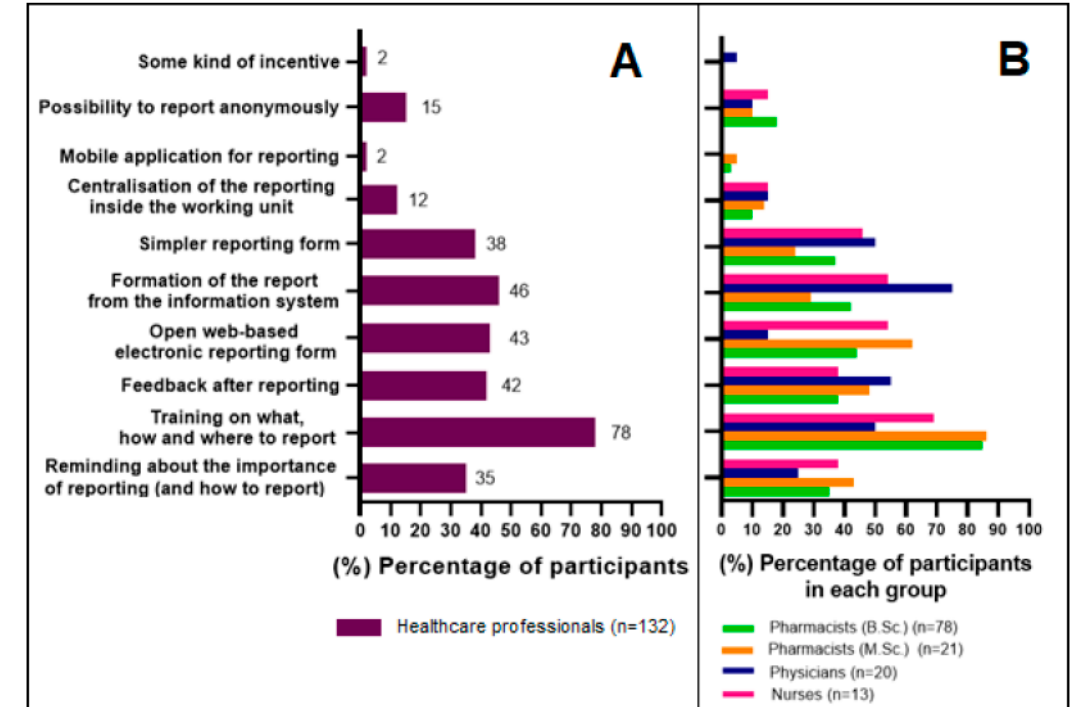
Figure 6. Healthcare professionals’ opinion about the most important factors that could increase the reporting of suspected adverse drug reactions. ( A ): All responses, percentage (%) of HCPs selecting the answer option. ( B ): Percentage (%) of HCPs selecting the answer option in each occupational group.